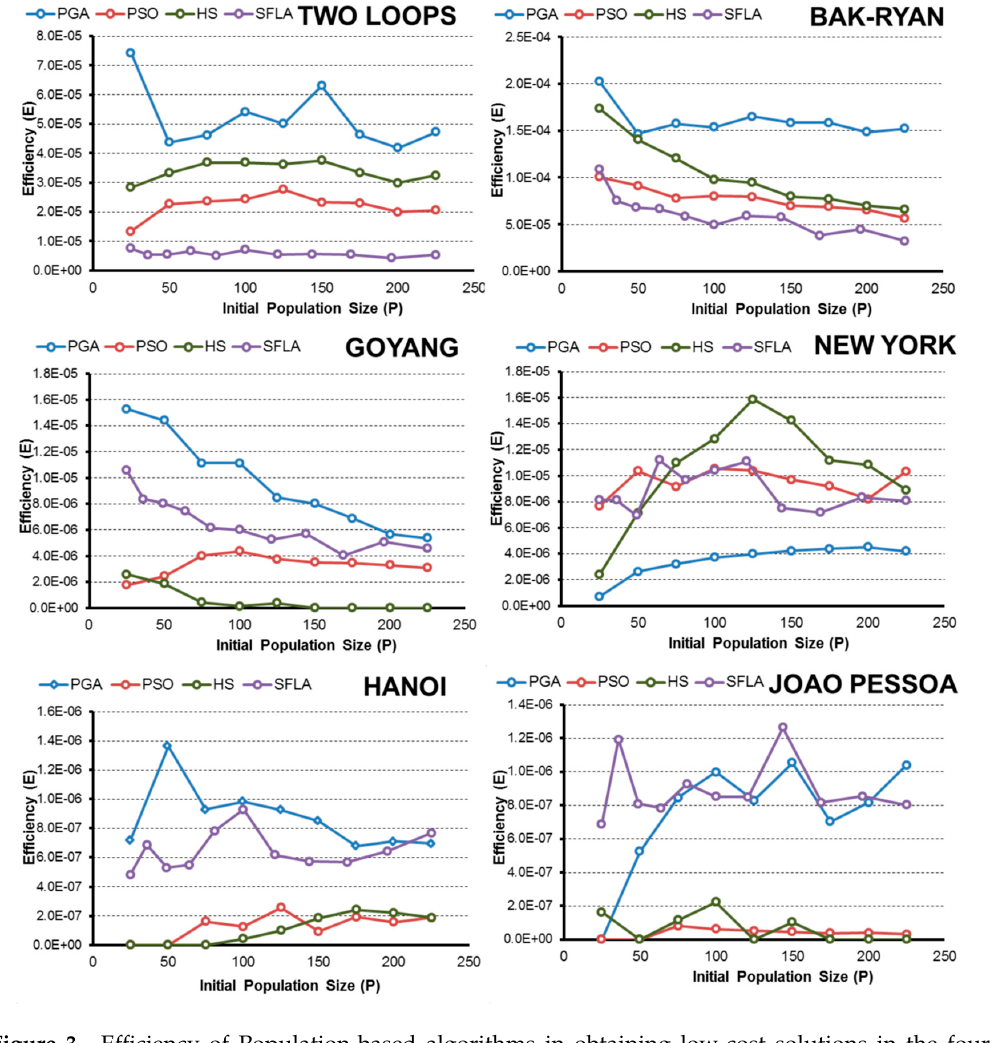
Figure 3. Efficiency of Population ‐ based algorithms in obtaining low ‐ cost solutions in the four selected networks.